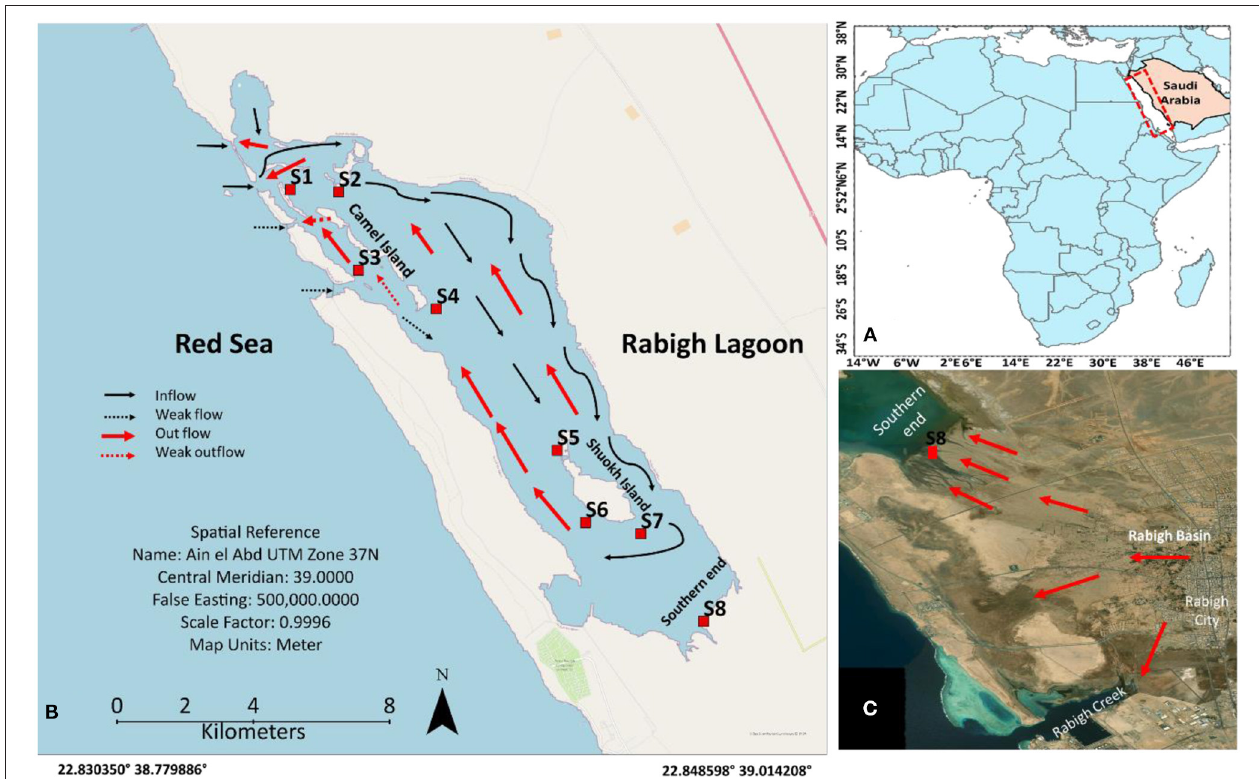
FIGURE 1 | Maps showing the west coast of Red Sea in Saudi Arabia (A) , Rabigh Lagoon along the Red Sea (B) , and the southern end of the lagoon with flood channels to the lagoon (C) . Red dots represent sampling